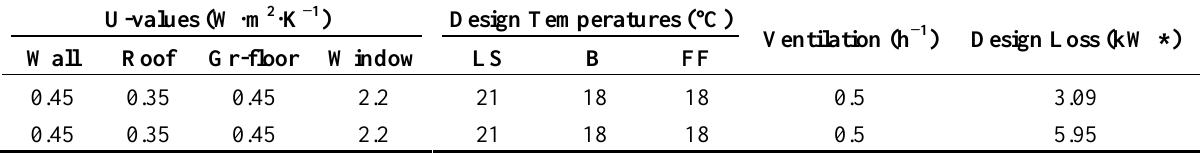
Table A2. Seasonal house energy modeling—thermal